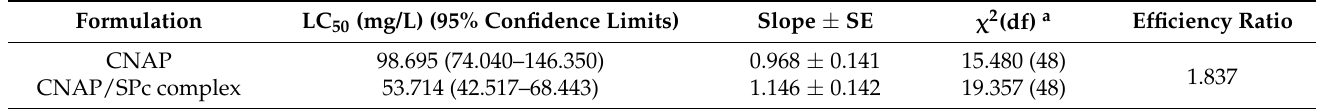
Table 3. Toxicity of CNAP and CNAP/SPc complex against 2nd instar nymphs of WFT at 24 h after the